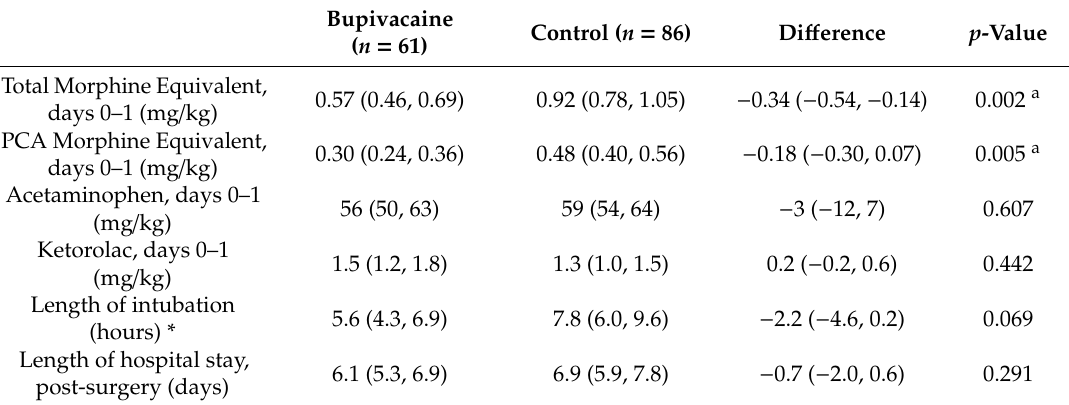
Table 6. Outcome characteristics (adjusted